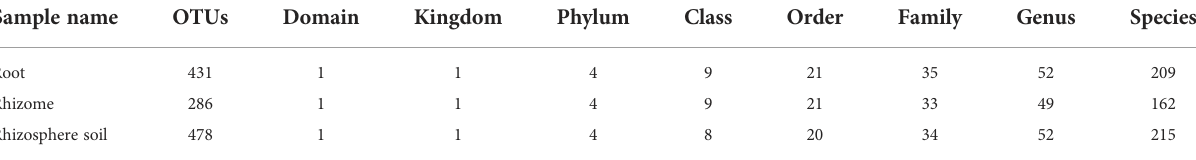
TABLE 3 OTU statistics of each classi fi cation level (Mycorrhizal